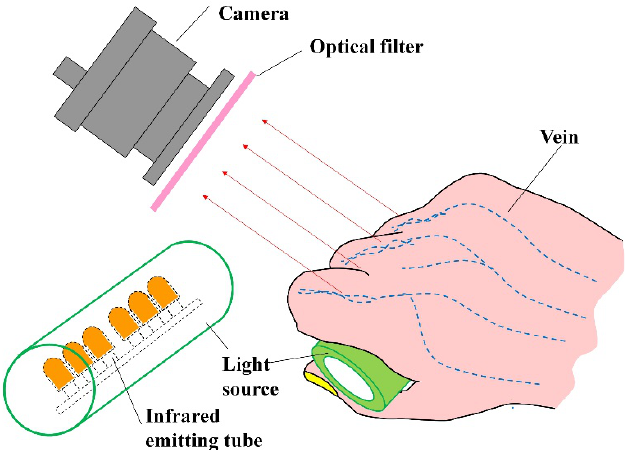
Figure 1. The diagram of the experimental device.